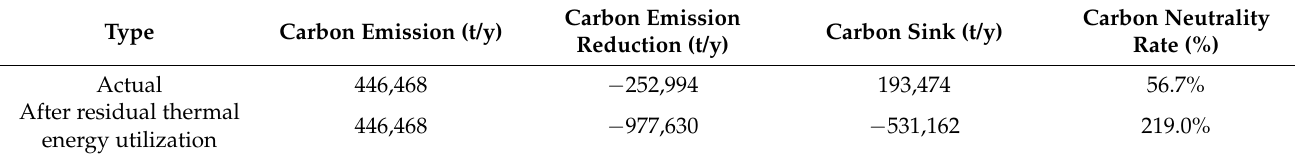
Table 9. Carbon footprint calculations.